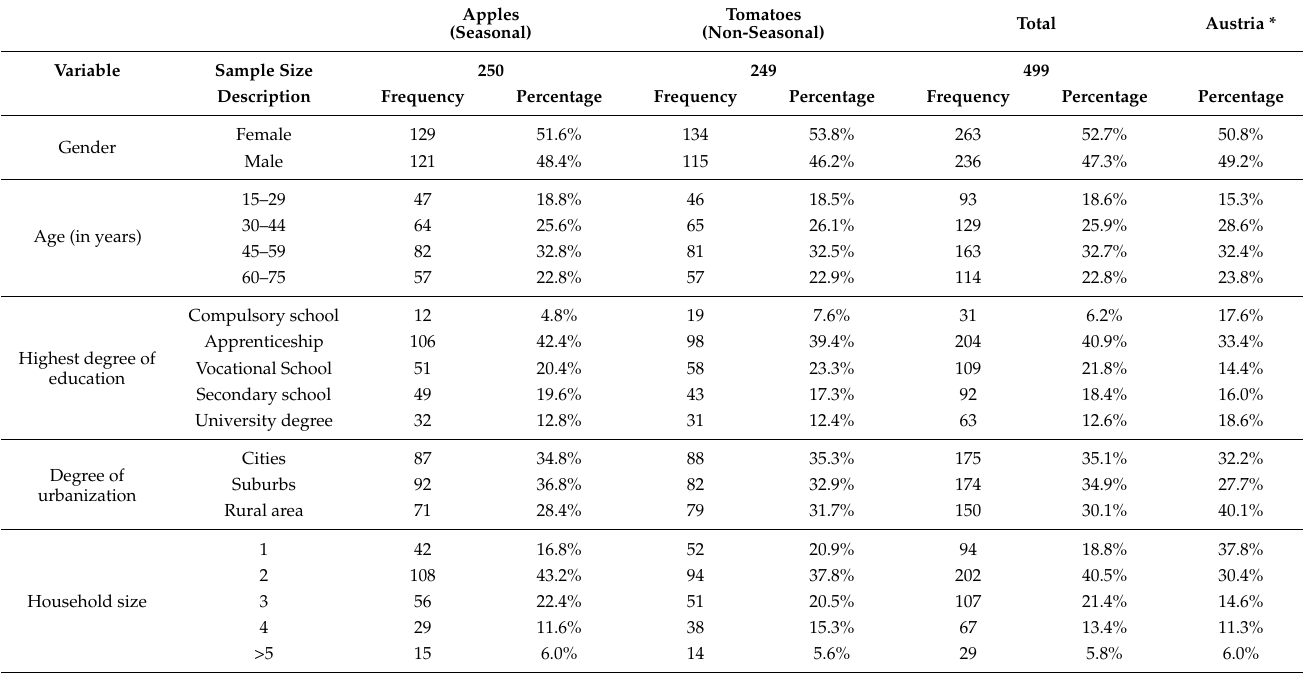
Table 2. Sociodemographic